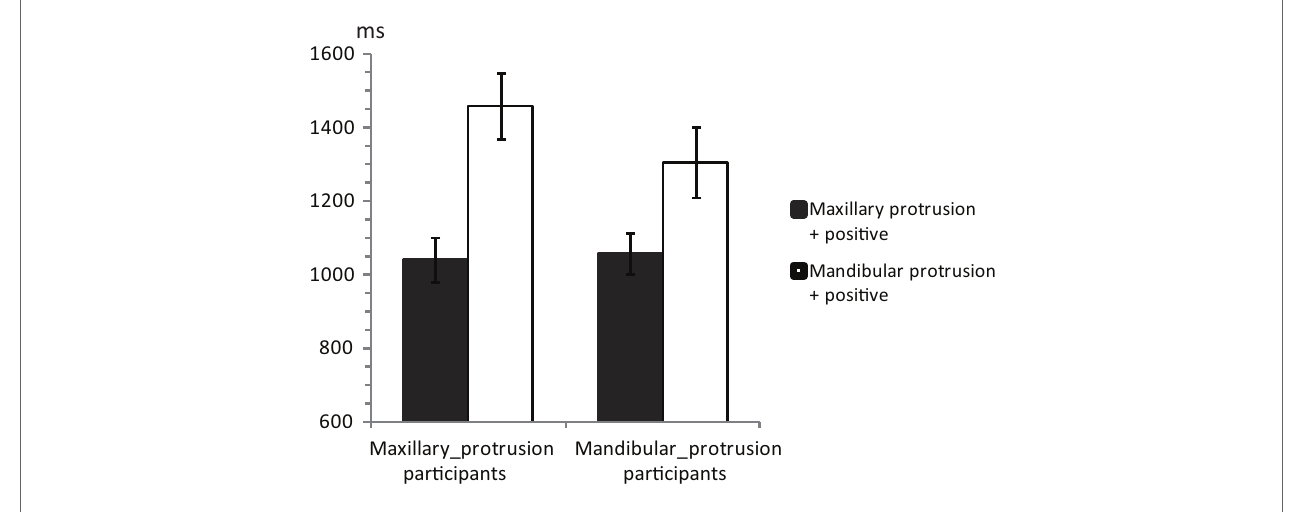
FIGURE 4 | Mean response times in the IAT for 48 participants with malocclusion. Mean response times for the conditions of maxillary-protrusion photographs + positive words (mandibular-protrusion + negative) are shown as dark gray bars. Mean response times for the conditions of mandibular-protrusion photographs + positive words (maxillary-protrusion + negative) are shown as white bars. The left two bars show the results for the participants with maxillary protrusion, and the right two bars show the results for the participants with mandibular protrusion. The error bars indicate the